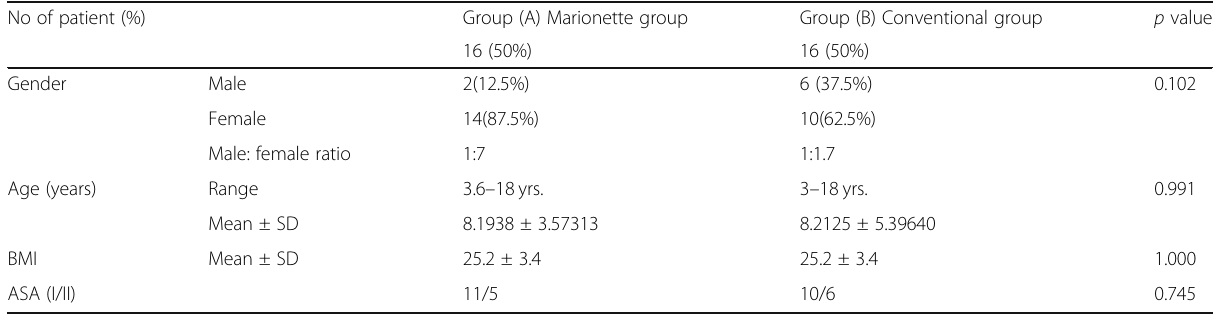
Table 1 Demographic of the two groups No of patient (%)